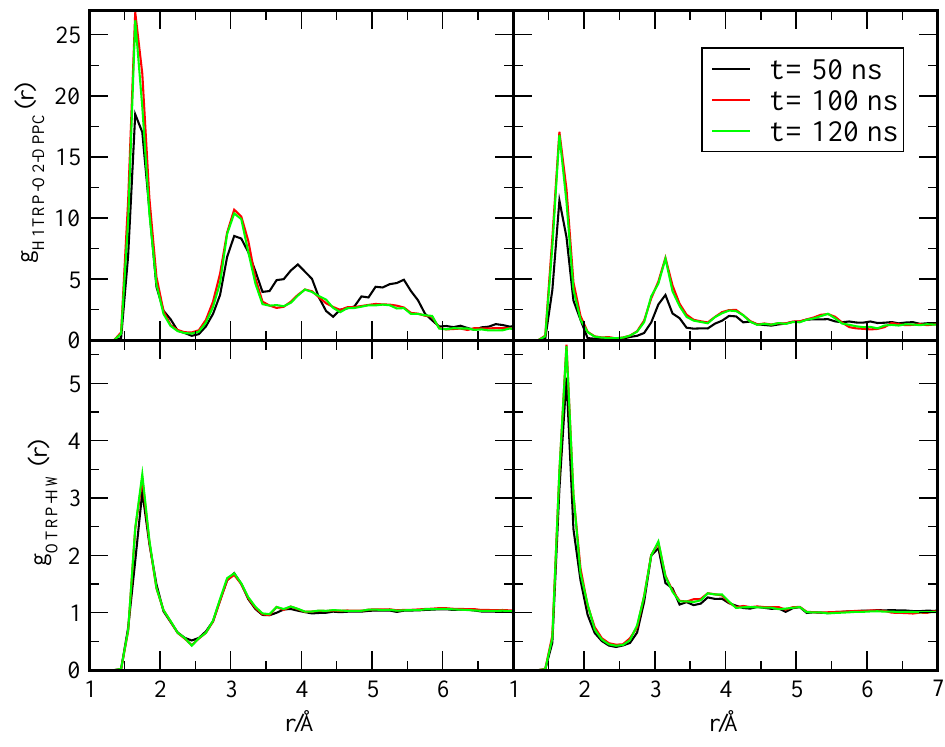
Figure A1. Convergence of MD simulations through RDF profiles as a function of simulation time for the production run of TRP in the DPPC and CHOL model